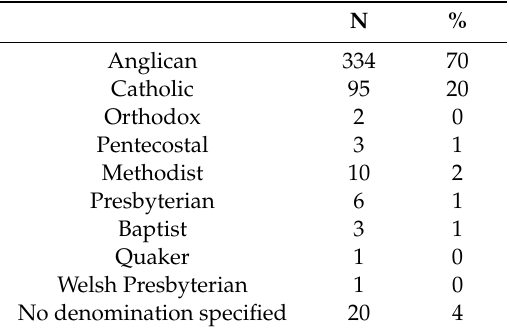
Table 9. Christian denomination.